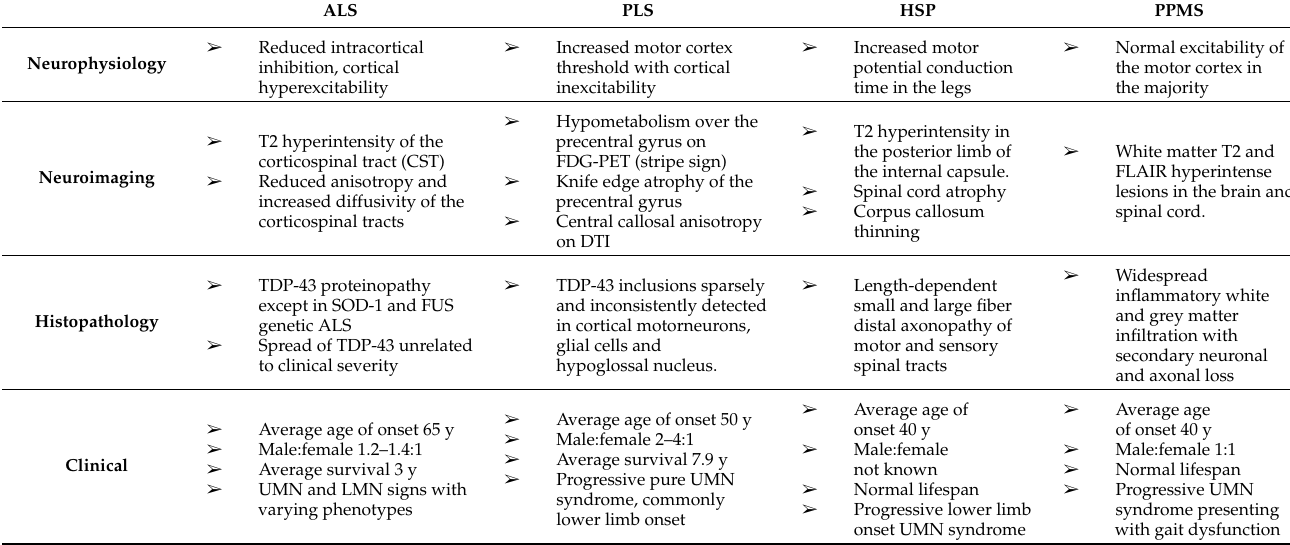
Table 1. Comparison of the clinical, imaging, neurophysiology and histopathology changes in ALS, PLS, HSP and PPMS. ALS PLS